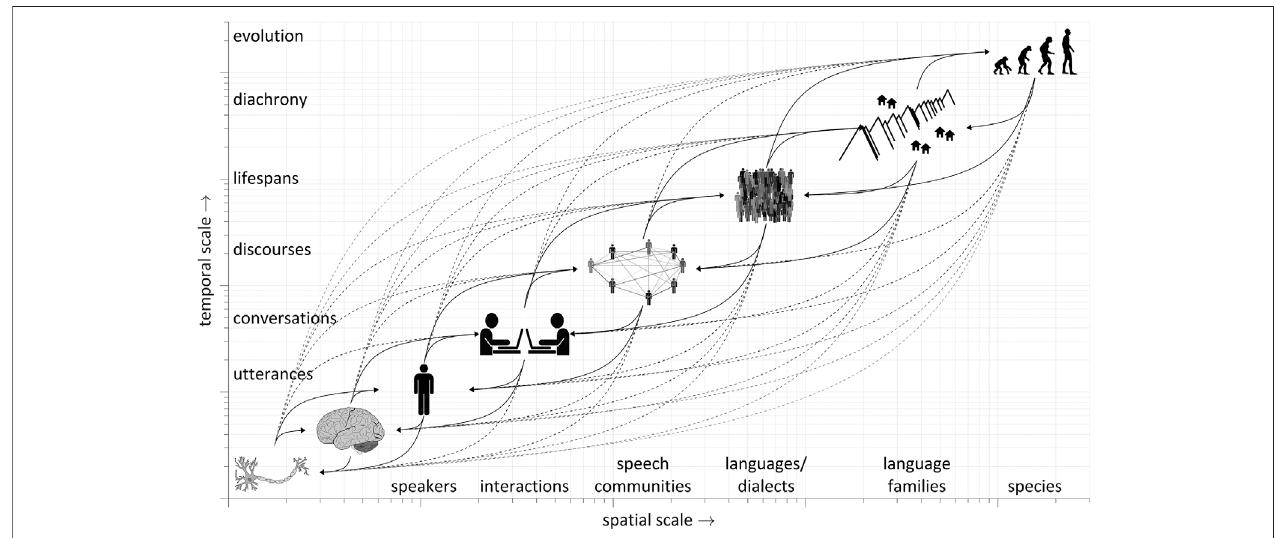
FIGURE 1 | The multi-scale nature of speech and bidirectional causality. Horizontal and vertical axes are used to indicate the spatial and temporal scales that are commonly used for characterizing the dynamics of systems. Labels for spatial and temporal scales are included. Systems across all scales interact.